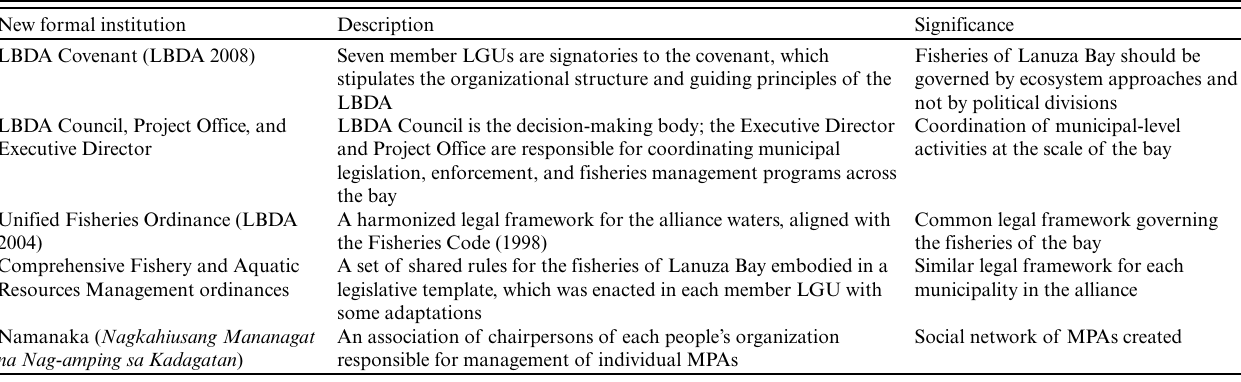
Table 2. New fisheries management institutions in Lanuza Bay, Philippines. LBDA = Lanuza Bay Development Alliance, LGU = local government unit, MPA = marine protected area.